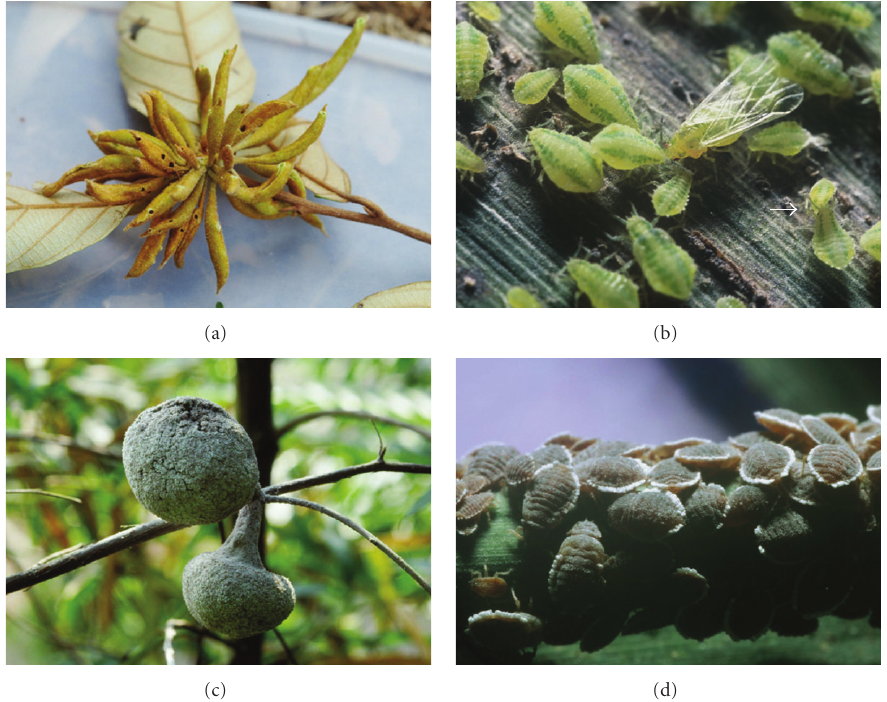
Figure 3: (a) A gall of Astegopteryx bambucifoliae (with many subgalls) on Styrax suberifolius (Sun Moon Lake, Taiwan; 25 September 1990). (b) A colony of A. bambucifoliae on a leaf of Bambusa sp.; a dueling pair is indicated by an arrow (Fushan, Taiwan; 22 April 2005). (c) A full grown gall of Ceratoglyphina styracicola (with two subgalls) on S. suberifolius (Sun Moon Lake; 13 December 1990). (d) A colony of C. styracicola on the bambusoid Pleioblastus sp. (Sun Moon Lake; 24 April